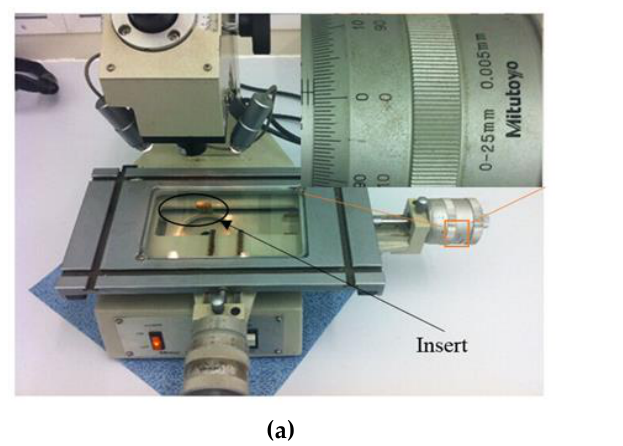
Figure 3. A typical tool wear, V B max, and different wear zones [26].